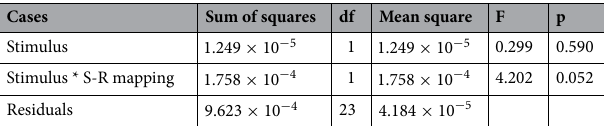
Table 1. Within subjects effects on